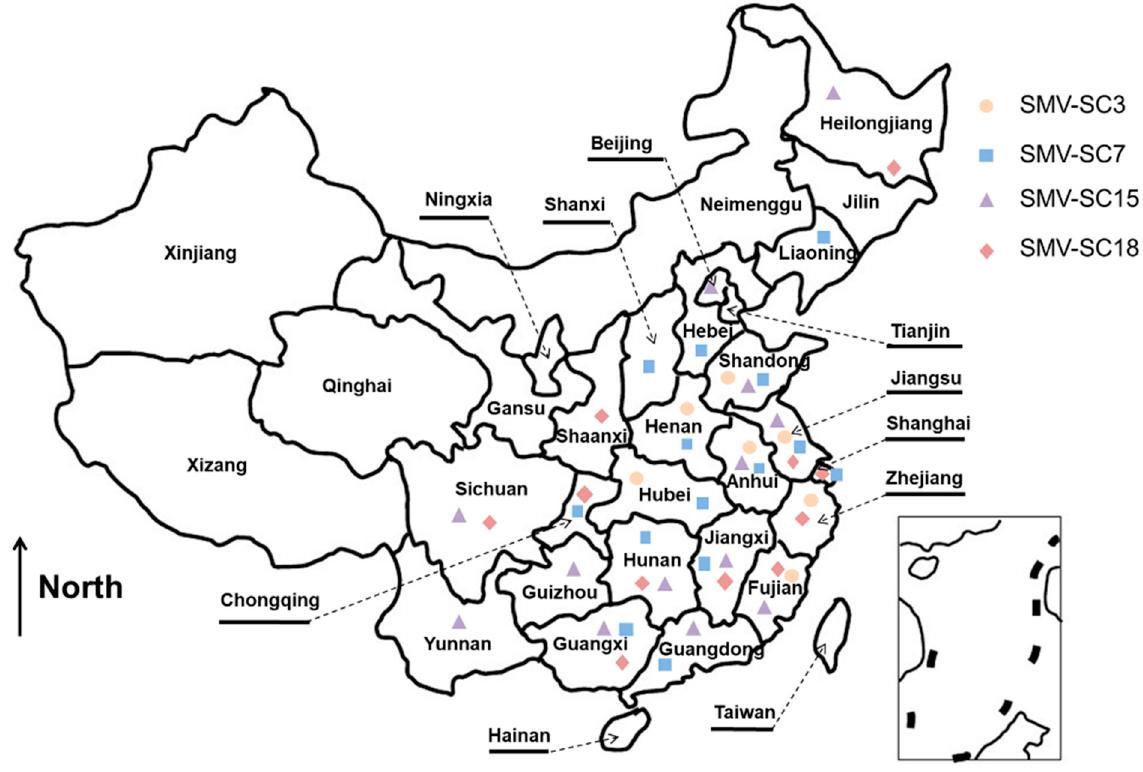
Figure 1. The geographical distribution of the four prevalent SMV strains, SC3, SC7, SC15 and SC18, in China. The orange dots, light-blue squares, purple triangle and brownish-red diamond indicate SMV strains collected in corresponding regions.